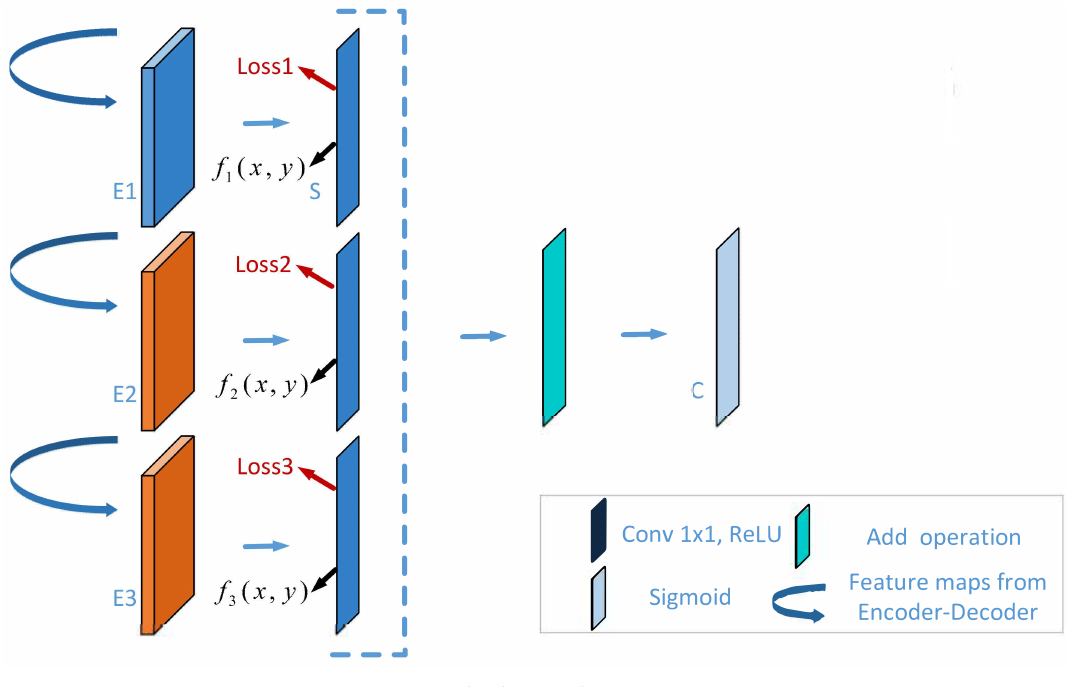
Figure 3. Coarse background suppression (CBS).